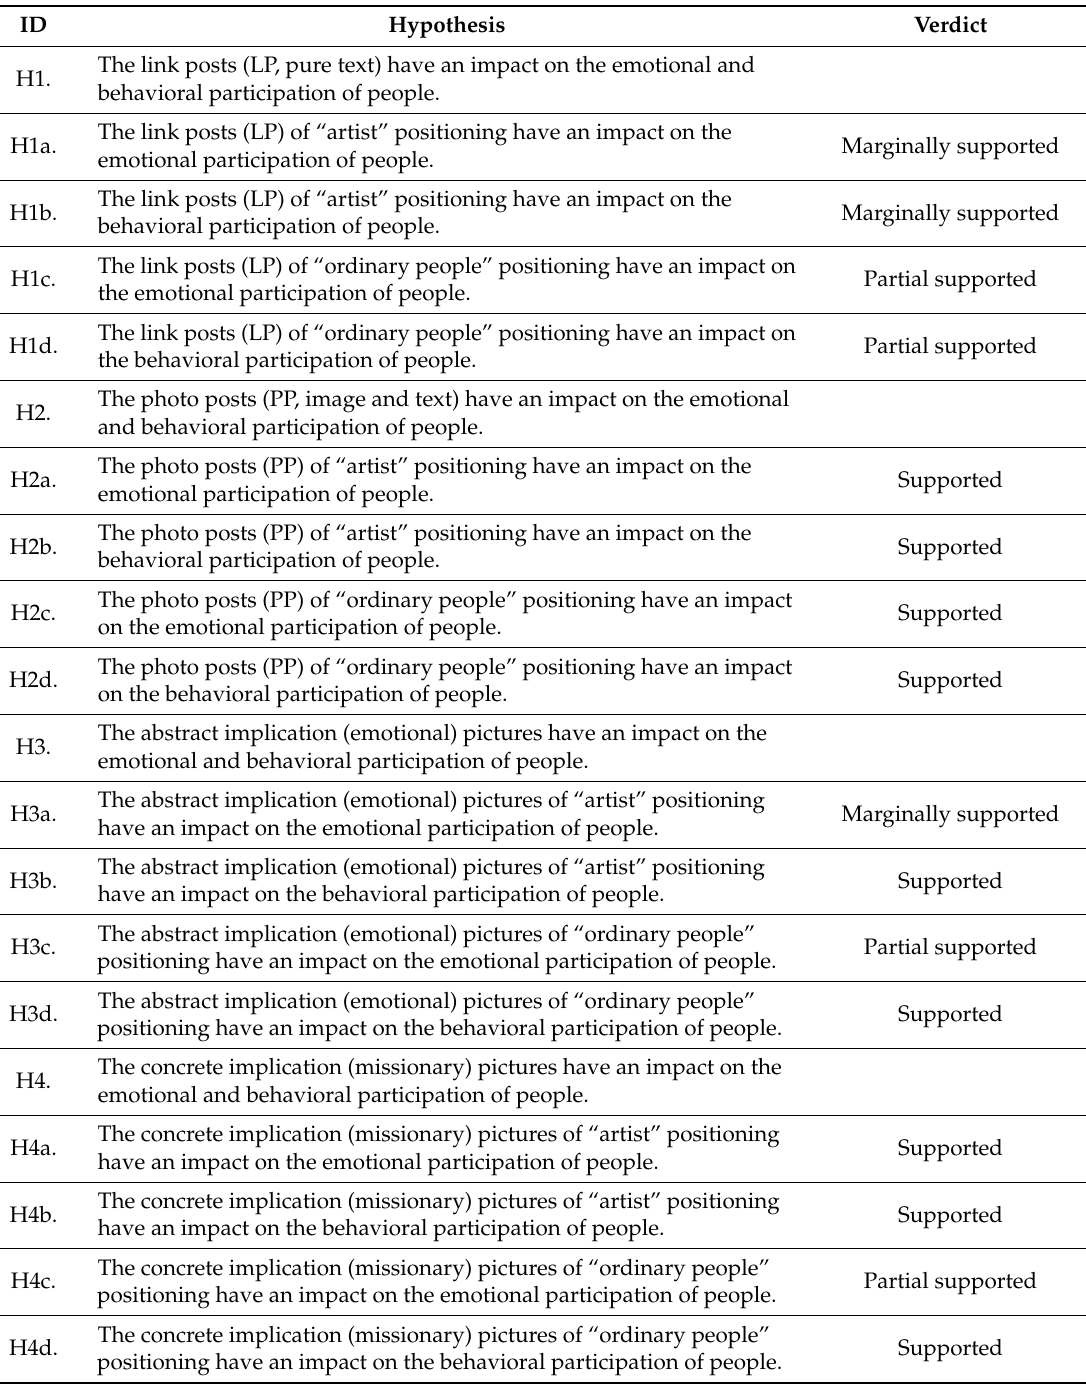
Table 2. Summary of